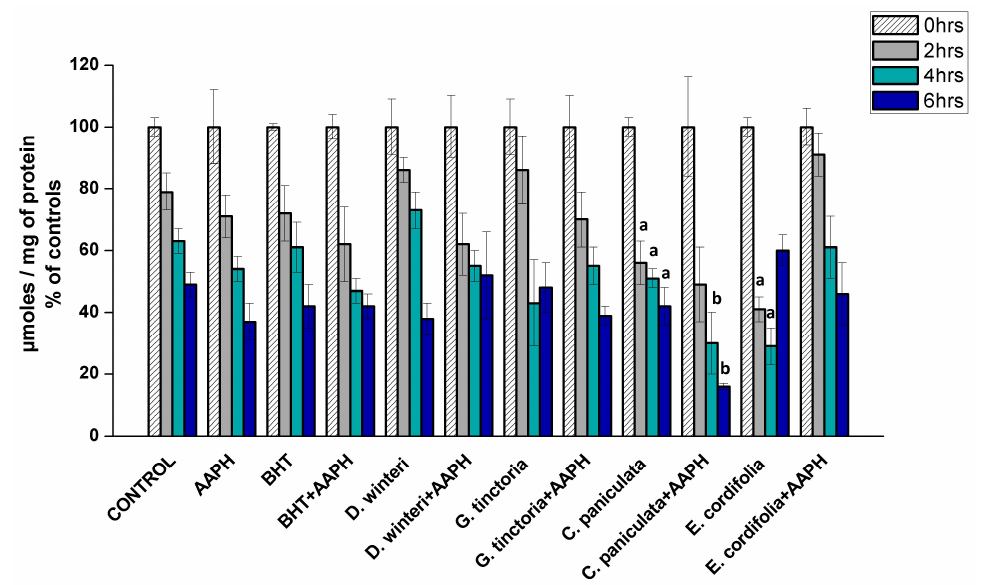
Figure 3. Content of thiols in the different samples analyzed, control, AAPH (10 mM), BHT (1 mM), and plant extracts (0.1 g/mL), (p < 0.05; a significant difference compared to control group; b significant difference compared to AAPH group, ANOVA, Tukey test). Data are expressed as percentage initial concentrations and represent the mean ± SD for of three replicates in triplicate.